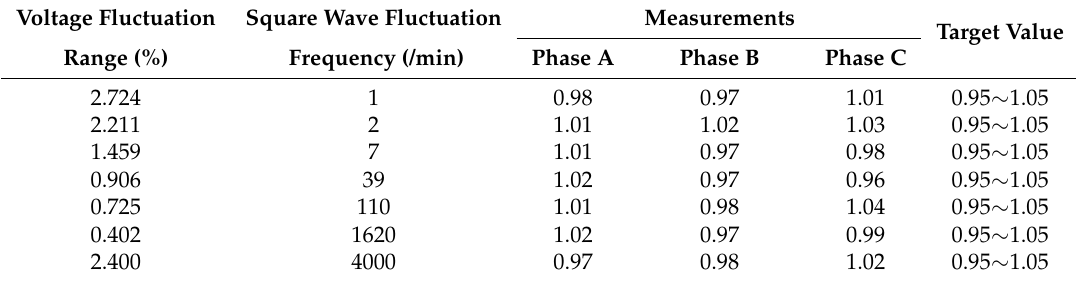
Table 3. Test results of